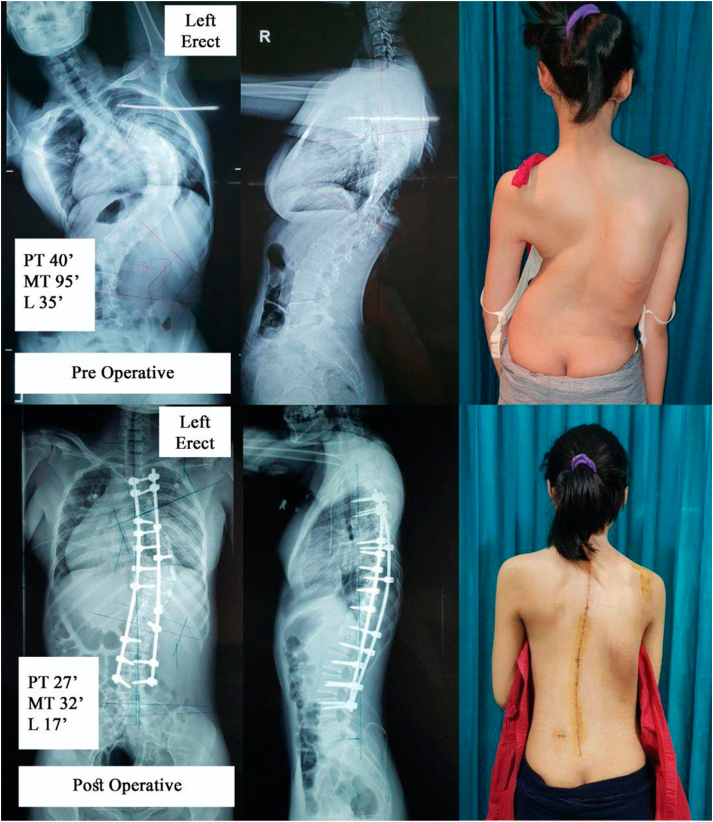
Female 20 years old treated with preoperative skull tong femoral traction. Initial Cobb angle was 95°, which was corrected to 32° (Main thoracic curve).